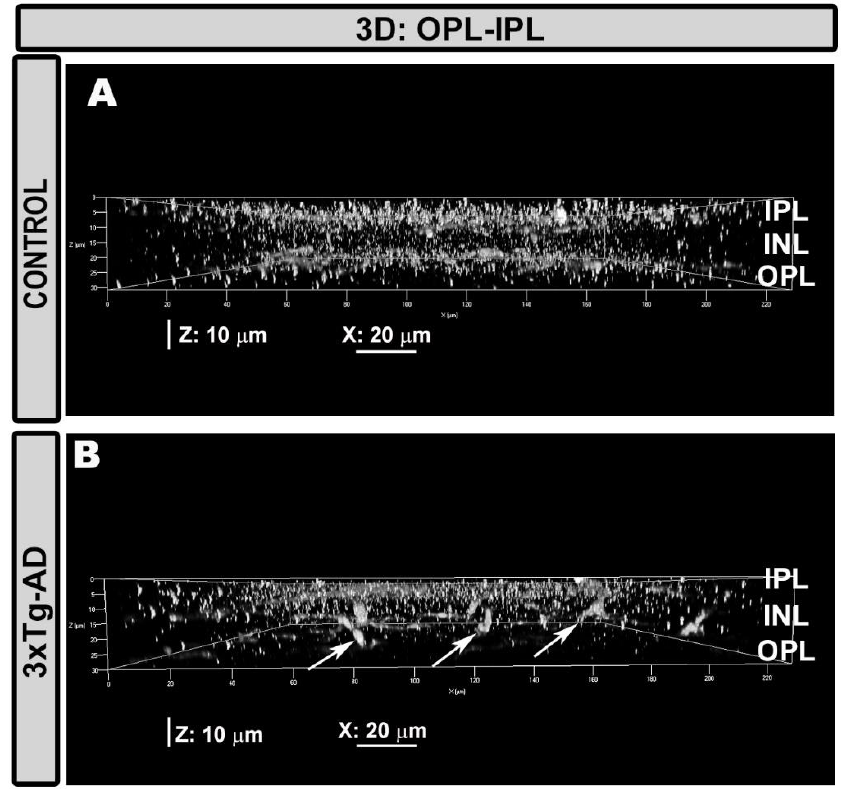
Figure 3. Iba-1 + cells among the IPL–OPL. Retinal whole-mount. Iba-1 immunostaining. Cut-view analysis on the YZ plane. In some retinal areas of 3xTg-AD mice ( B ), some Iba-1 + cells were arranged perpendicular to the retinal plane (arrow) and were observed to occupy the IPL, INL, and OPL. This was not seen in the age-matched control group ( A ).